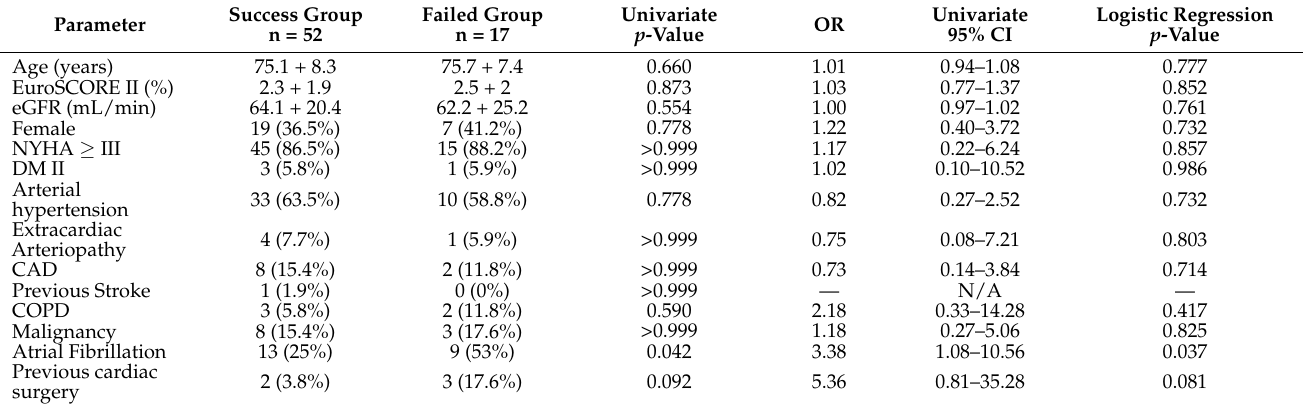
Table 5. Univariate analysis using descriptive statistics and univariate logistic regression analysis on baseline demographic and clinical characteristics (69 patients, 3-year follow-up, outcome: MR